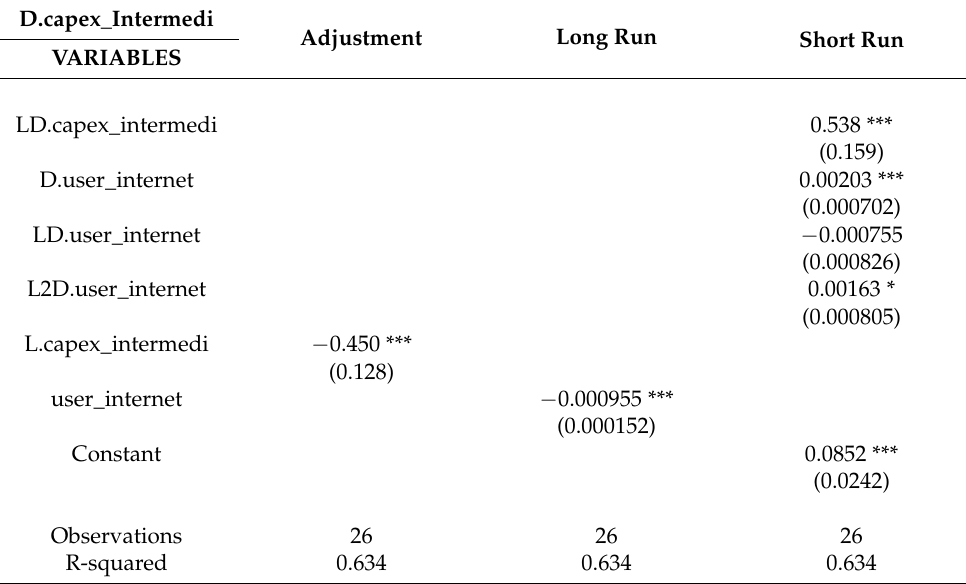
Table 5. Model 2—impact of digital transformation on operational capital cost efficiency